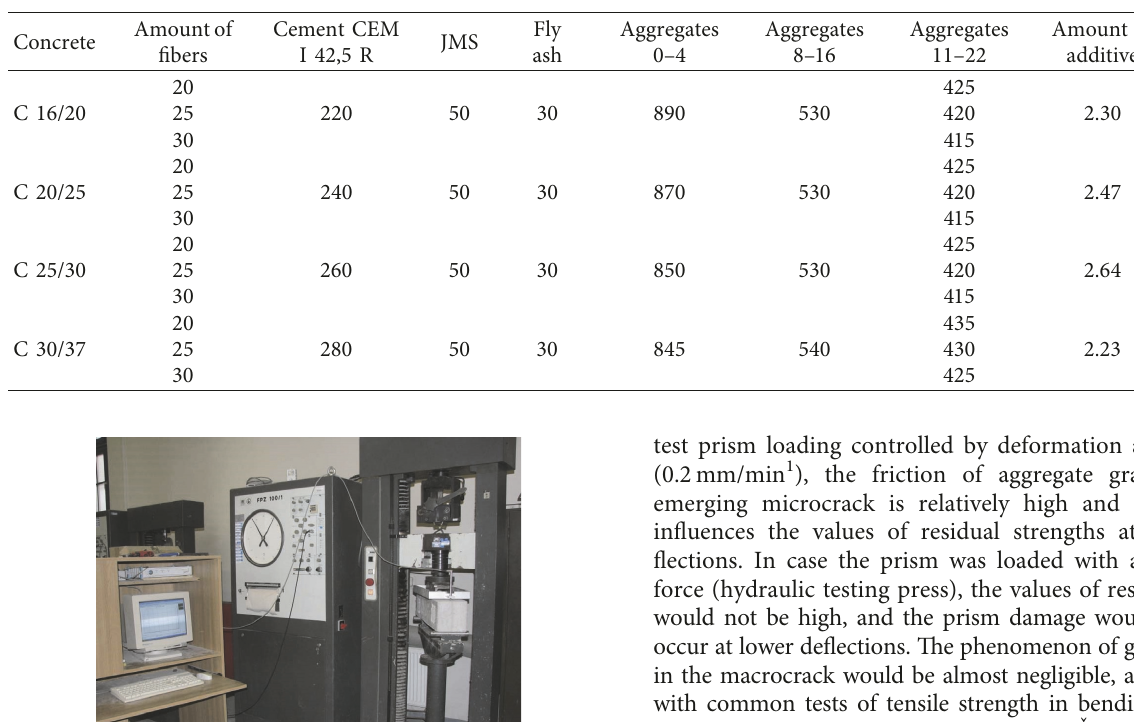
Table 4: Composition of the steel fiber reinforced concrete mixtures in kg per m 3 .